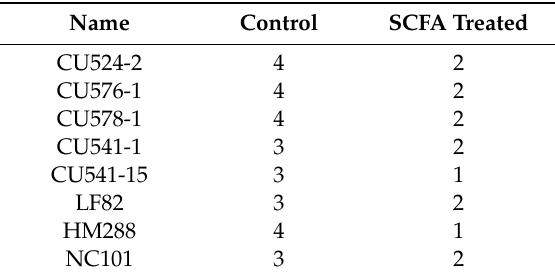
Table 5. Yeast agglutination scores *.